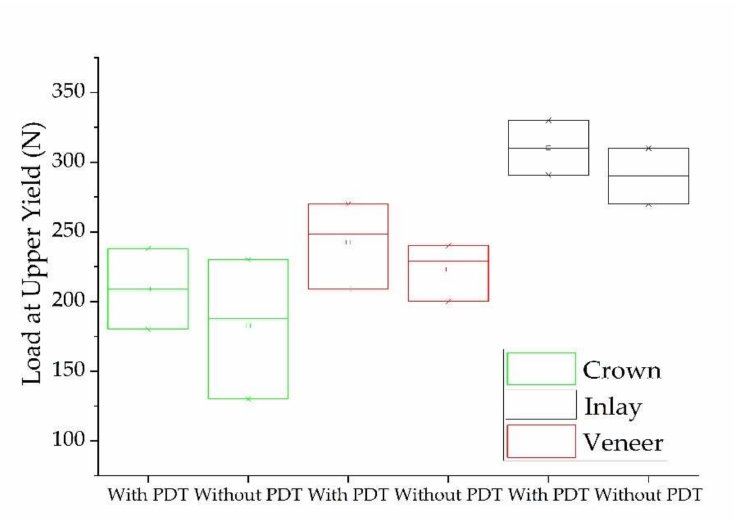
Figure 5. Comparison of load at upper yield between examined groups with and without